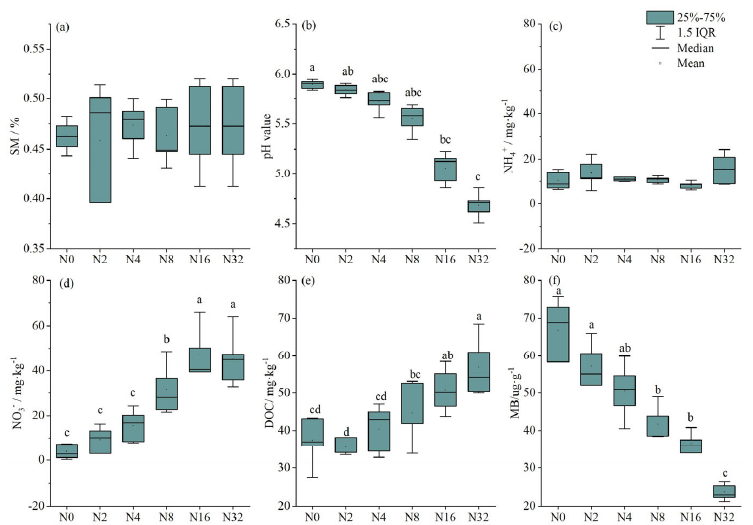
Figure 1. Boxplots showing the physico-chemical properties of the soils with different N application rates. ( a ) Soil moisture (SM), ( b ) pH, ( c ) NH 4+ contents, ( d ) NO 3 − contents, ( e ) DOC contents, and ( f ) microbial biomass (MB). In all, 25–75% represents the interquartile range (IQR). The different low ‐ ercase letters indicate significant differences among all the N application treatments ( p < 0.05). N0 is the control (0 g N ∙ m − 2 ∙ yr − 1 application), N2 is the 2 g N ∙ m − 2 ∙ yr − 1 application, N4 is the 4 g N ∙ m − 2 ∙ yr ‐ 1 application, N8 is the 8 g N ∙ m − 2 ∙ yr − 1 application, N16 is the 16 g N ∙ m − 2 ∙ yr − 1 application, and N32 is